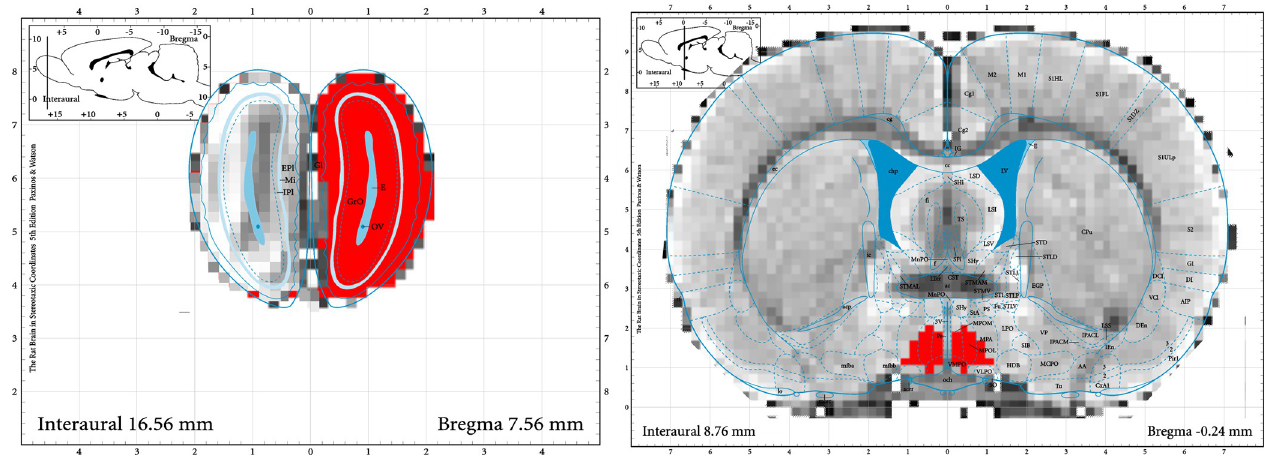
Fig 6. Examples of ROIs using the atlas of Paxinos as reference [36]. From left to rigth, the olfactoy bulb and the medial preoptic area.